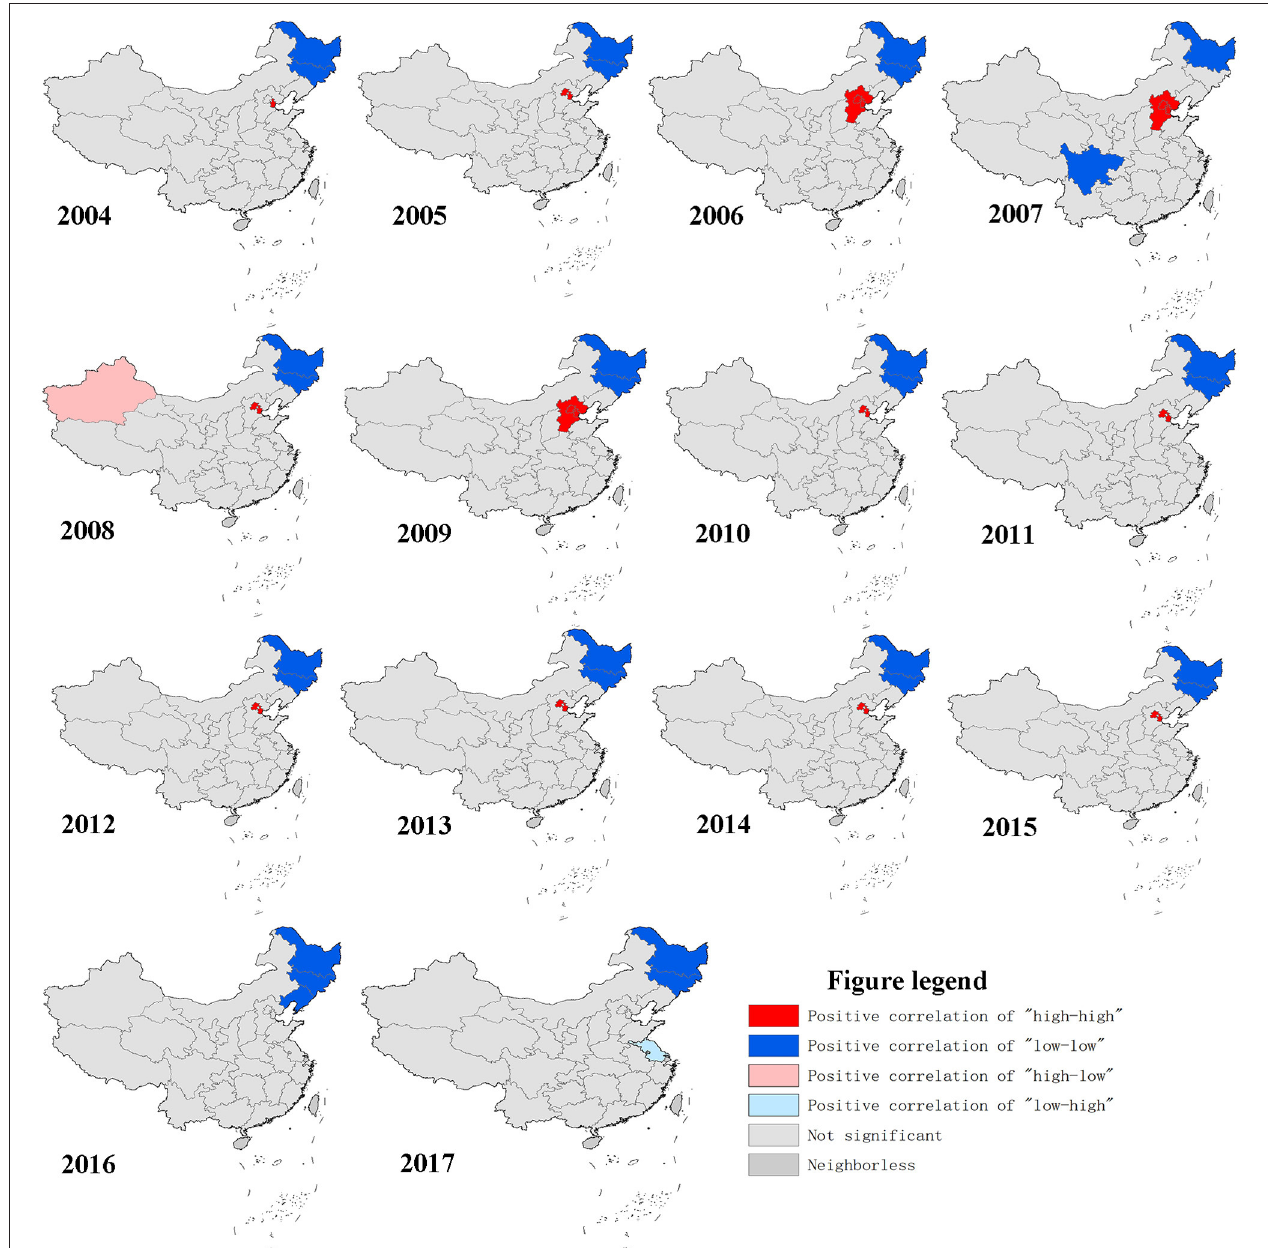
FIGURE 3 | Geographical distribution characteristics of other infectious